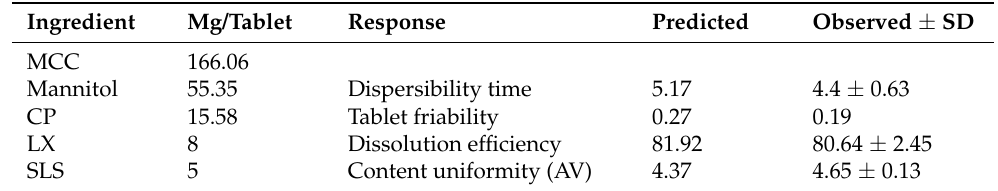
Table 5. Composition and predicted, observed values of the responses for the optimized LX dis- persible tablet